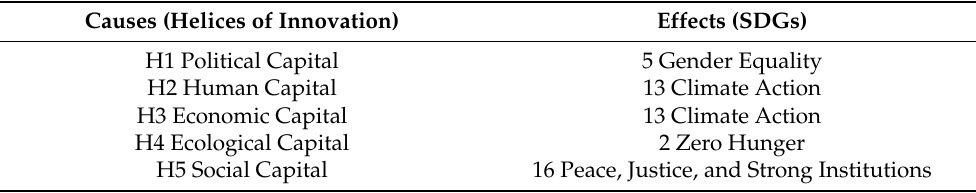
Table 3. Cause-effect relationships.